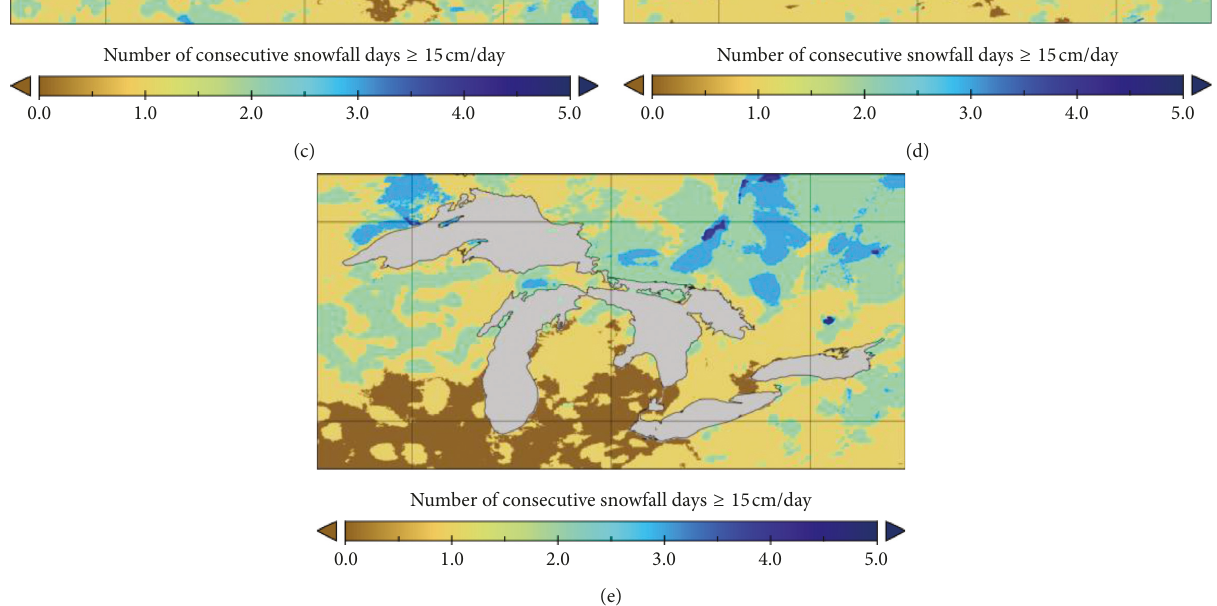
Figure 4: Extreme snowfall duration for each month of the cold season: (a) November, (b) December, (c) January, (d) February, and (e) March. Extreme snowfall duration is defined as the maximum number of consecutive days for which daily snowfall amounts equaled or exceeded S_threshold of 15cm/day between 1980 and